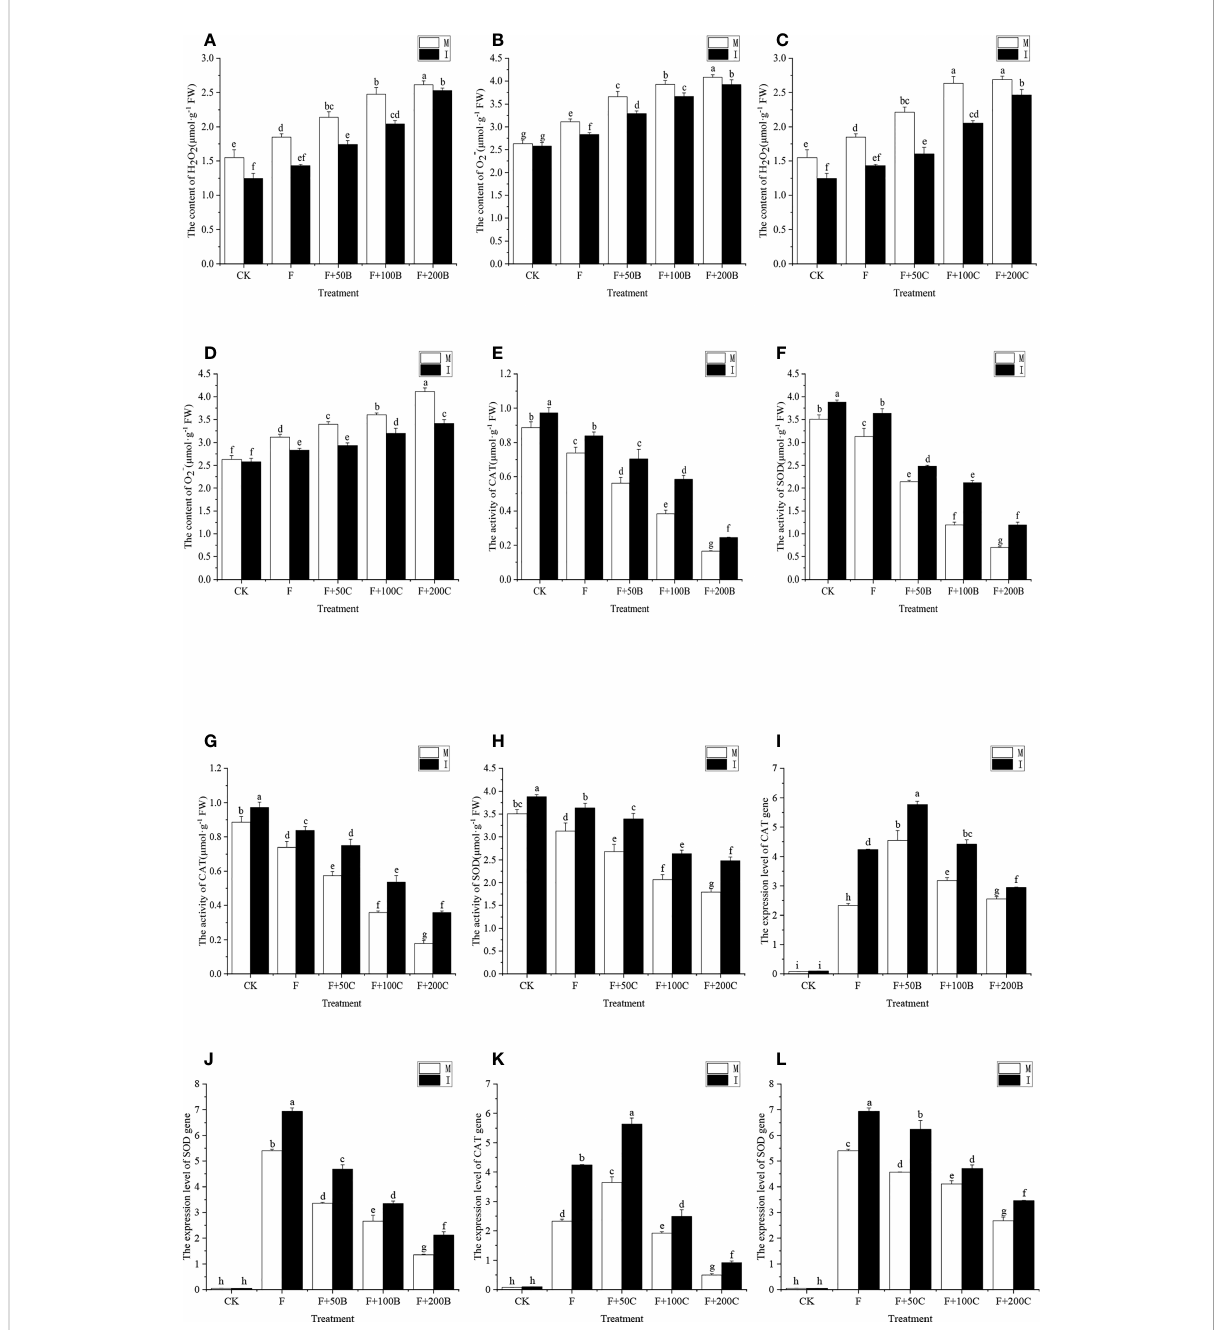
FIGURE 4 Effects of different concentrations of benzoic acid on root (A) H 2 O 2 and (B) O 2 − of faba bean ( Vicia faba ) inoculated with F under different cropping modes. Effects of different concentrations of cinnamic acid on root (C) H 2 O 2 and (D) O 2 − of root faba bean inoculated with F under different cropping modes. Effects of different concentrations of benzoic acid on SOD activity in the root modes (E) and CAT (F) of faba bean ( Vicia faba ) inoculated with F under different cropping modes. Effects of different concentrations of cinnamic acid on SOD (G) and CAT (H) in root modes of faba bean inoculated with F under different cropping systems. Effects of different concentrations of benzoic acid on (I) CAT and (J) SOD expression in the root modes of faba bean ( Vicia faba ) inoculated with F under different cropping modes. Effects of different concentrations of cinnamic acid on the levels of expression of (K) CAT and (L) SOD in the root system of faba bean inoculated with FOF under different cropping modes. Different letters for each index indicate signi fi cant differences at p < 0.05 (Tukey ’ s test). F, Fusarium oxysporum f.